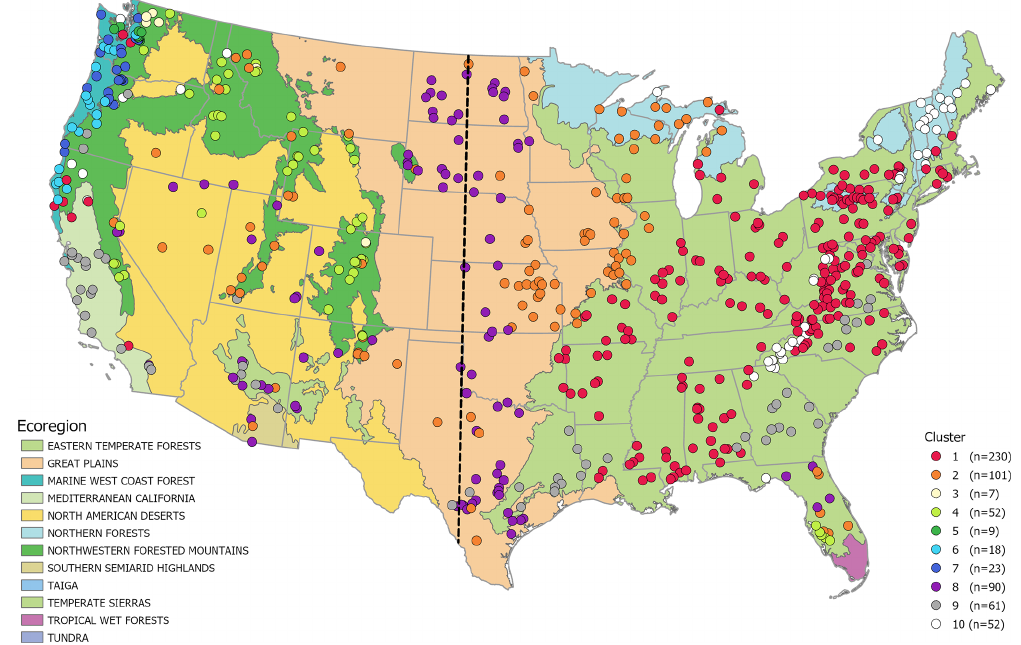
Figure 4. Locations of the clustered CAMELS catchments and level I ecoregions (Omernik and Griffith, 2014) in the continental US. Dotted line marks the 100th meridian. An interactive version of this map can be found at https://zutn.github.io/Catchment-Classification/map.html (last access: 26 February 2020).